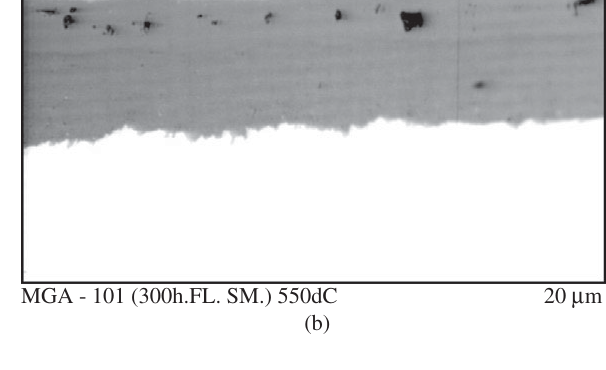
Figure 2. Scale growth kinetics for materials grown using differ- ent laboratory procedures: a) low alloy ferritic steels; b) 9Cr1Mo martensitic steel.